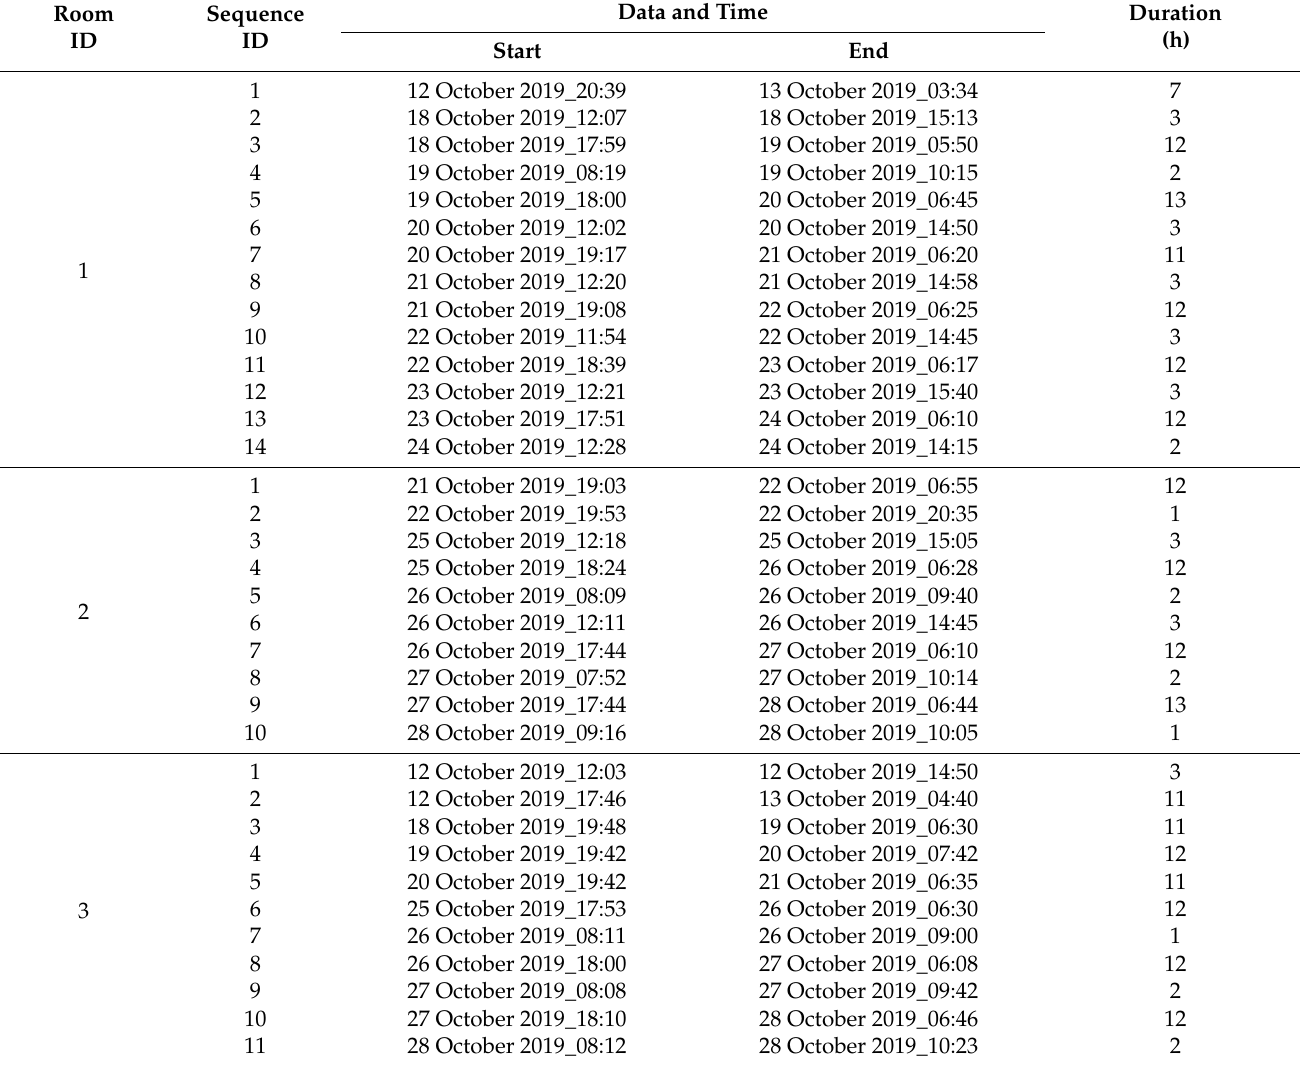
Table 1. Long sequences from the